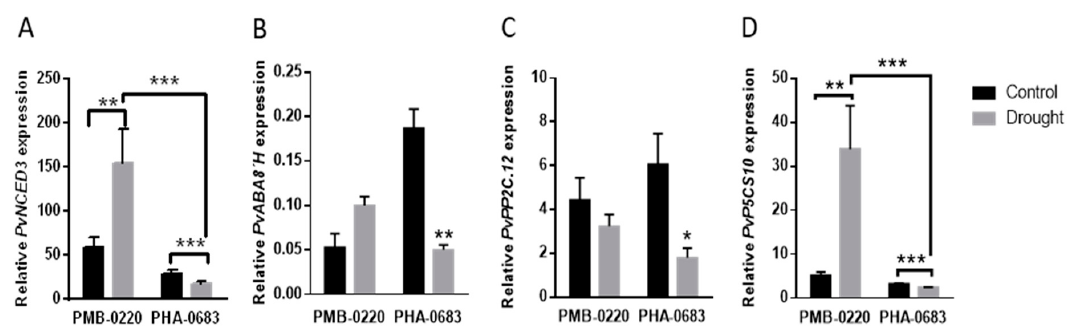
Figure 3. Relative expression of abscisic acid (ABA)-related genes in leaves from control and 10 days-drought-stressed plants of PMB-0220 and PHA-0683 lines, grown under symbiotic nitrogen fixation conditions. Relative expression of ( A ) PvNCED3 ; ( B ) PvABA8’H ; ( C ) PvPP2C.12 and ( D ) PvP5CS10 in response to drought. Data were means of three independent samples and asterisks indicate statistically significant differences (* p < 0.05) (** p < 0.005) and (*** p < 0.0005).